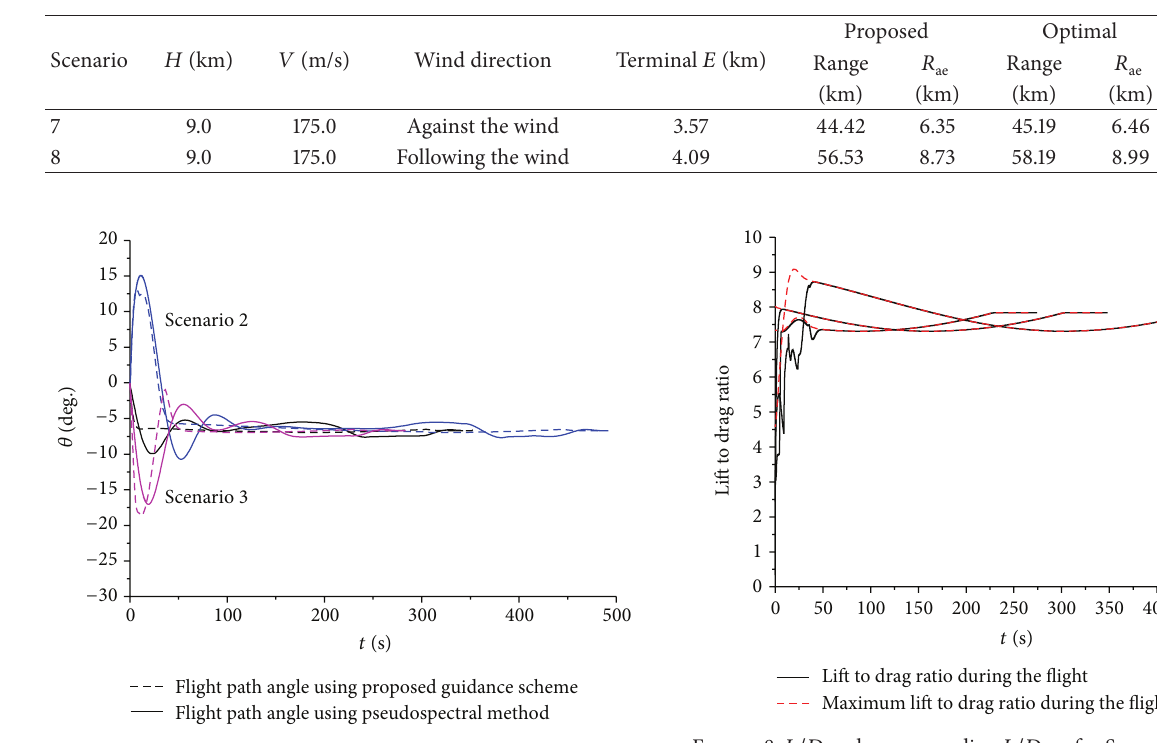
Figure 6: Flight path angles for Scenarios 1, 3, and 6.